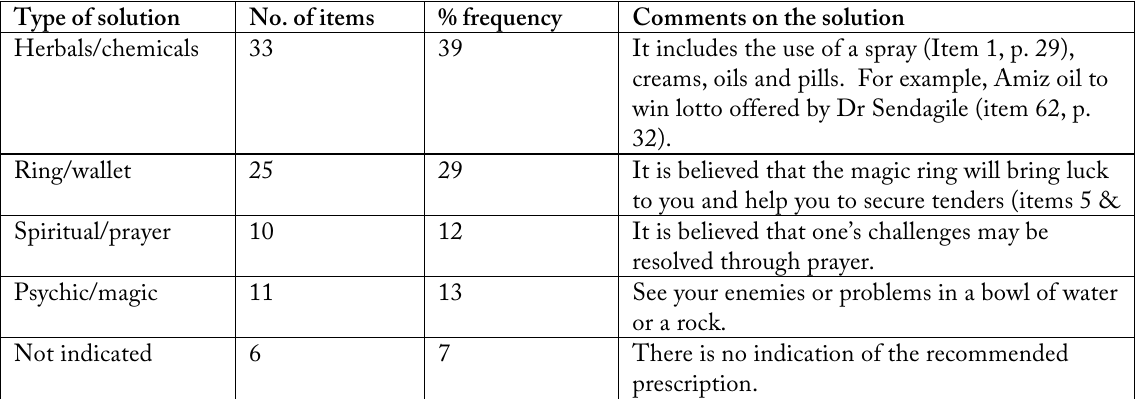
Table 1: Frequent solutions mentioned in the items Type of solution No. of items % frequency Com ments on the solution